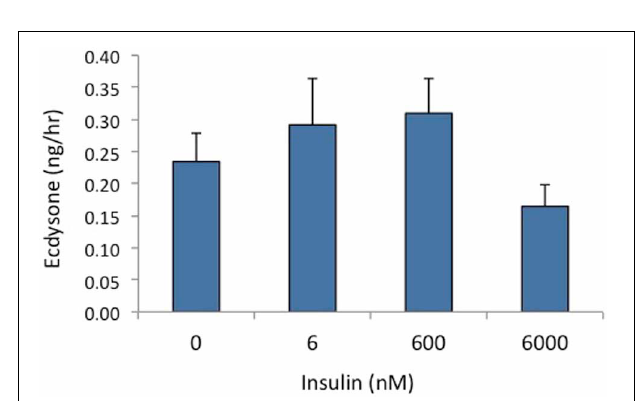
FIGURE 2 | Effects of insulin on ecdysone secretion. Prothoracic glands from day 2 fifth instar larvae were incubated for 80min in designated concentrations of insulin, and culture medium was assayed for ecdysone ( n = 9–14 glands per group). None of the insulin-treated groups differed from controls (ANOVA, Tukey–Kramer post-hoc test, p >